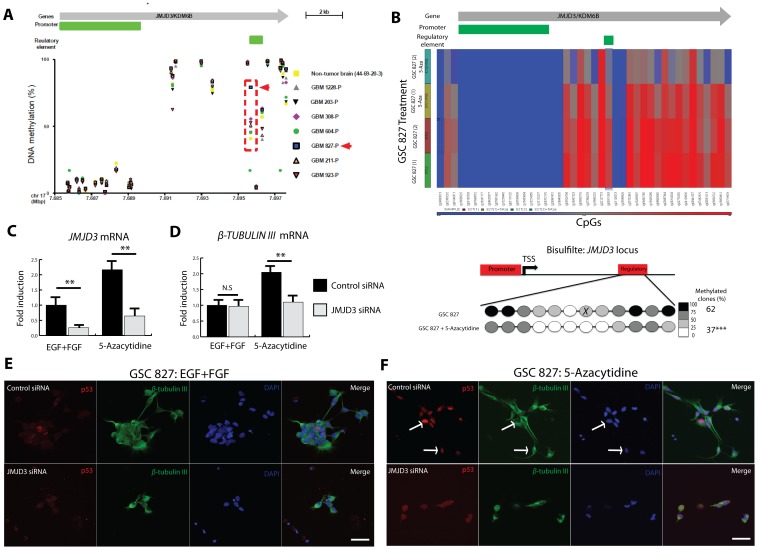
Regulatory element DNA demethylation re-activates JMJD3 mRNA in GSC 827. A,
Illumina Infinium Human Methylation 450 bead chip methylation arrays on parental GBM tumor samples (GBM-P) compared to non-tumor brain tissue (Non-tumor brain 44-69-20-3) showing the methylation status (0%-unmethylated, 100%-hypermethylated) of JMJD3 regulatory regions (Chromosome 17. UCSC NCBI 36/Hg 18). B, (Top) Heat map from whole genome DNA methylation profiling showing that 5-Azacytidine reproducibly demethylates the JMJD3 regulatory element (from 2 independent experiments). (Bottom) Bisulfite sequencing confirmed JMJD3 regulatory element in GSC 827 demethylation following 5-Azacytidine treatment. No significant changes were found at the promoter. X indicates cg09911083. C–D, Effect of 5-Azacytidine on JMJD3 mRNA (C) expression as well as differentiation markers β-TUBULIN III (TuJ1) (D) in GSC 827. JMJD3 SMARTpool siRNA knockdown inhibits 5-Azacytidine induced differentiation of GSC 827. E–F, Immunocytochemistry of GSC 827 showing the effects of JMJD3 knockdown on p53 nuclear accumulation before (E) and after (F) 5-Azacytidine treatment as assessed by morphology and β-TUBULIN III expression. Arrows pointing to differentiated GSCs with nuclear p53. Scale bar represents 20 µm. All experiments were done in triplicates. Error bars represent means ±SD. p = two-tailed Student’s t test comparing indicated samples to EGF+FGF control, *p<0.1, **p<0.05, ***p<0.01, N.S.- not significant.